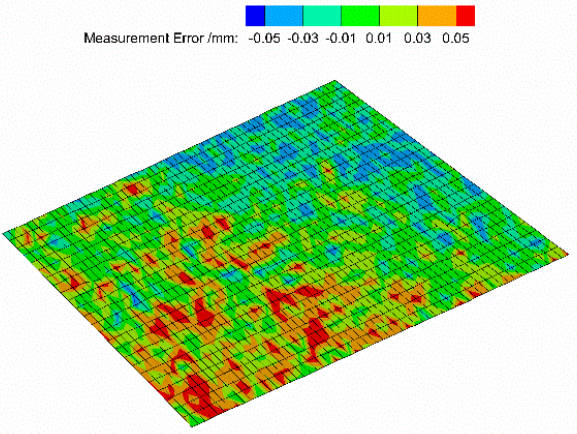
Figure 4. Measurement system error range.